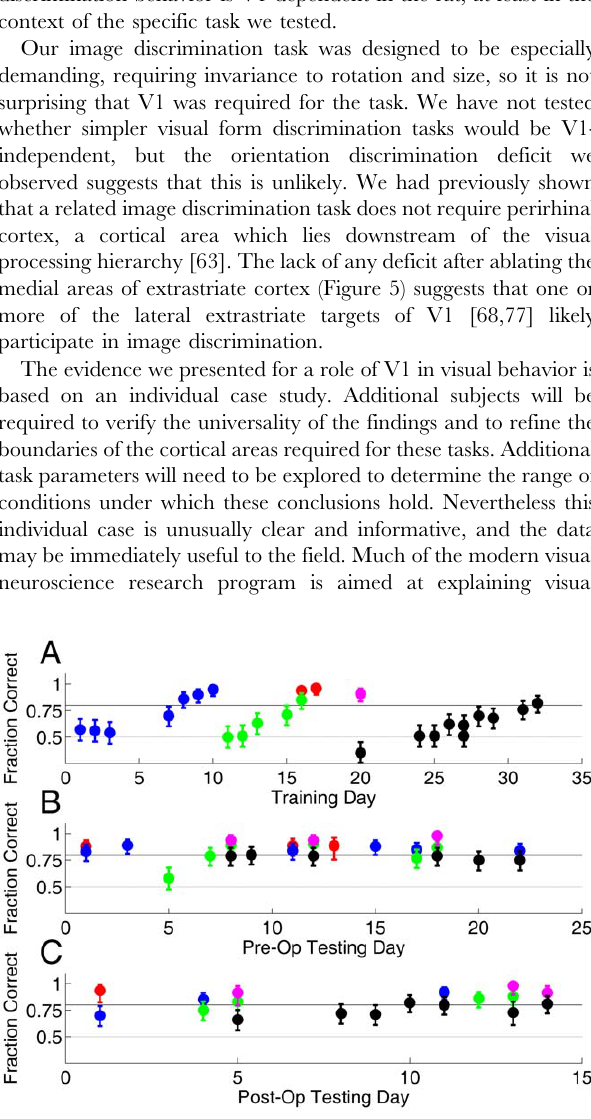
Figure 4. Lesion boundaries for subject S1. A. Summary of lesion boundaries. This subject had extensive bilateral damage to area V1. The estimated Right Side % V1 damage was 97%. The estimated Left Side % V1 damage was 84%. The only sparing of V1 tissue was at the most extreme lateral edges that formed the border of V2 and the sparing was slightly more extensive on the left side. Some minor sparing also occurred to the thin lateral band of V1 and extends most anterior. Extra V1 damage occurred to V2 that borders the medial aspect of V1 and the retrosplenial cortex. Minor damage also occurred to the post subiculum and the dentate gyrus. B. Sample section through V1 illustrating quality and extent of the damage attained by ibotenic acid injection.